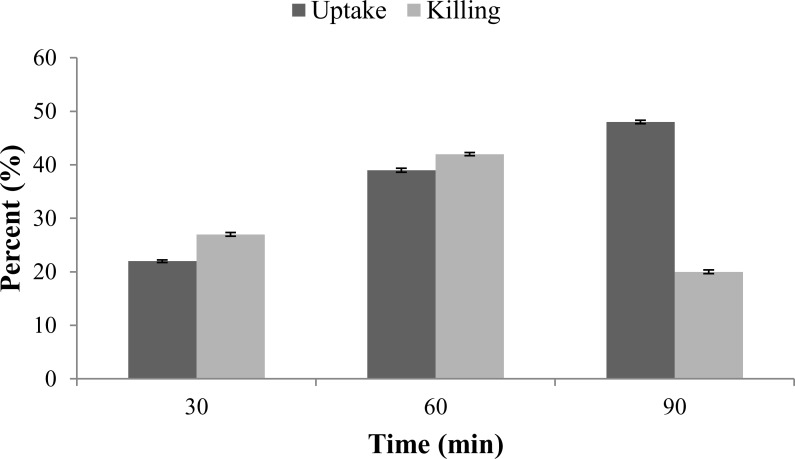
Percent bacterial uptake and killing by mouse peritoneal macrophages at different time intervals.All values represent the mean ± SEM, calculated from two independent experiments, each performed in duplicate on different occasions. SEM represent the 95% confidence interval. Confidence interval is calculated as SEM * 3.18. Raw data is available in Table 2.